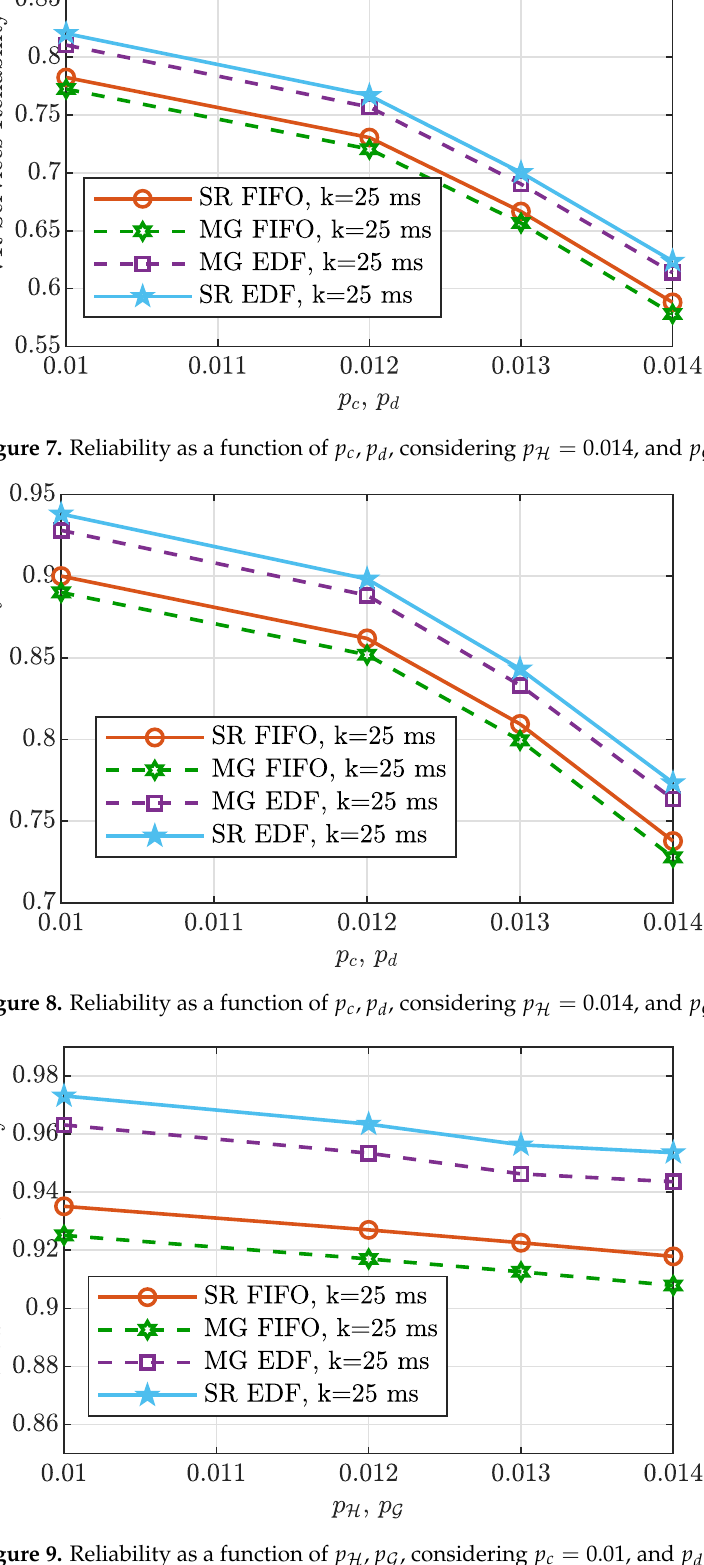
Figure 9. Reliability as a function of p H , p G , considering p c = 0.01, and p d =